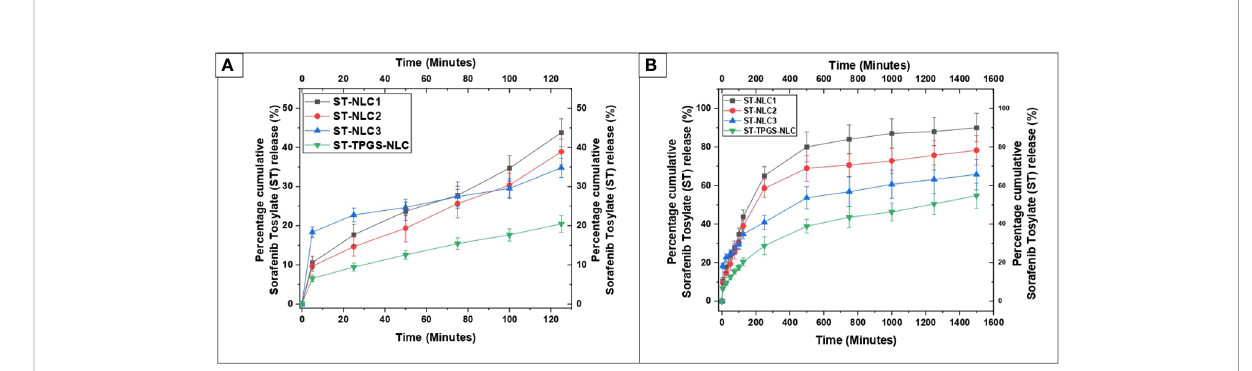
FIGURE 6 In vitro drug release pro fi le of ST-NLC1-3 and ST-TPGS-NLC in phosphate buffer containing 0.5% Polyoxyethylene sorbitan monooleate. (A) . Percentage cumulative sorafenib tosylate (ST) release pro fi le from nanoparticles up to 120 minutes (B) . Percentage cumulative sorafenib tosylate (ST) release pro fi le from nanoparticles up to 1600 minutes. The data were expressed as the mean ± SD, with